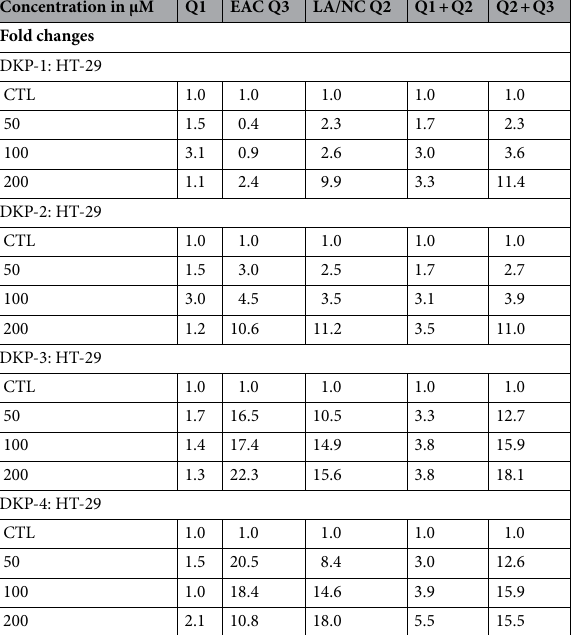
Table 2. Cyclic dipeptides induces apoptosis in HT-29 cells in a dose-dependent manner. Annexin V-FITC/ PI double staining was performed to analyze apoptotic cell populations. HT-29 cells were treated with different doses of four DKPs as an indicated time for 24 h. Data are representative of three independent experiments (n = 3). DKP -1—cyclo (l-Pro-l-Leu), DKP -2—cyclo (l-Pro-l-Val), DKP -3—cyclo (l-Pro-l-Phe),